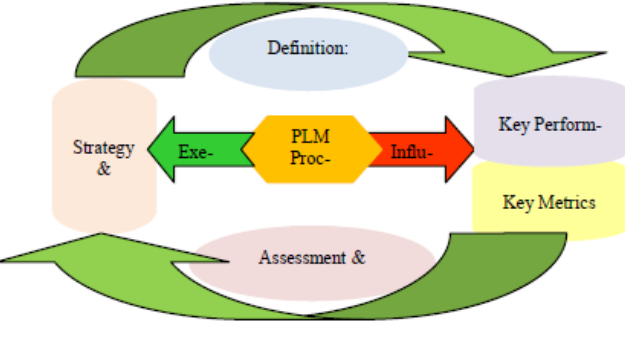
Figure 2. “PLM Assessment Process